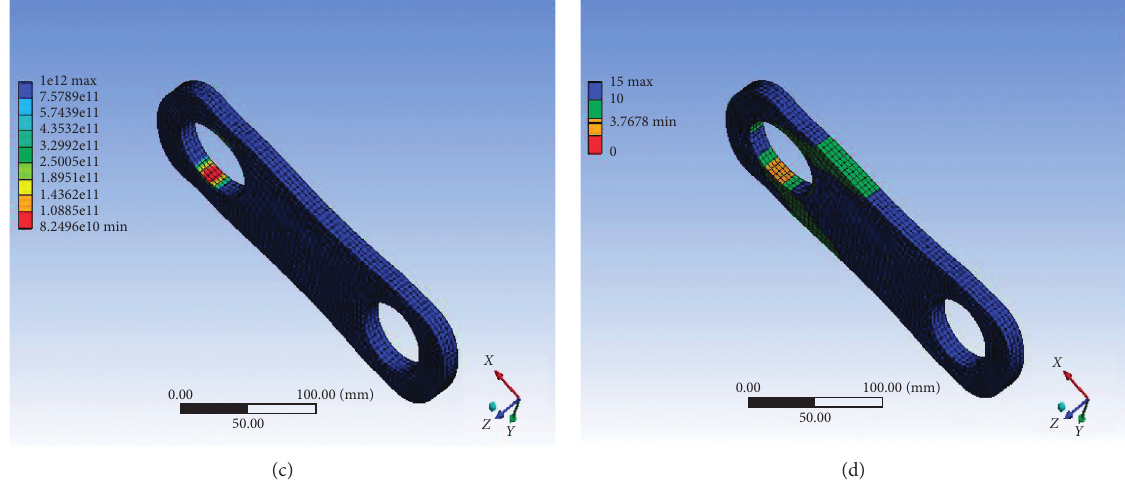
Figure 18: Simulation results for chain link with a modeled crack and neck radius 2488.4mm ( X � 5mm): (a) equivalent stress, (b) deformation, (c) fatigue life, and (d) safety factor.